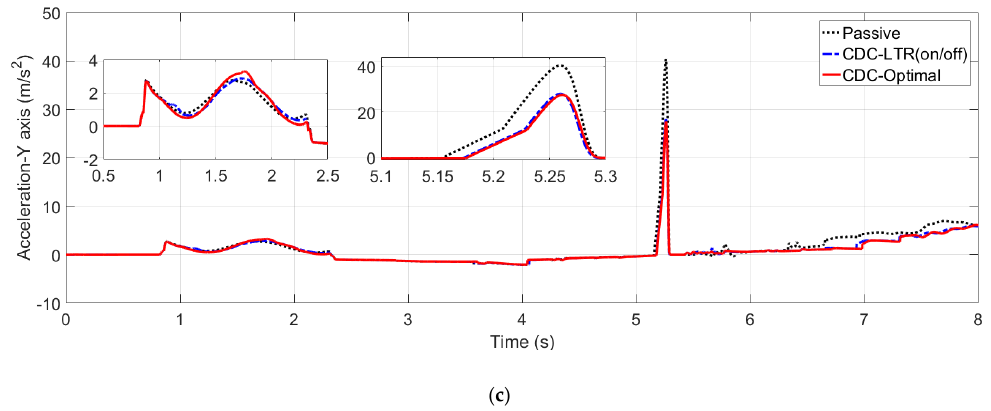
Figure 9. Roll angle rate, LTR, and lateral acceleration of crosswind test. The result of passive suspension is expressed by the black dotted line. The result of CDC-LTR is expressed by the blue chained line. The result of CDC-ODDF is expressed with the red solid line. ( a ) is the comparison result of the roll angle rate. ( b ) is the comparison result of LTR. ( c ) is the comparison result of lateral acceleration. To observe the comparison of the two CDC control strategies more conveniently, a local view, in which the passive suspension is removed, is added.